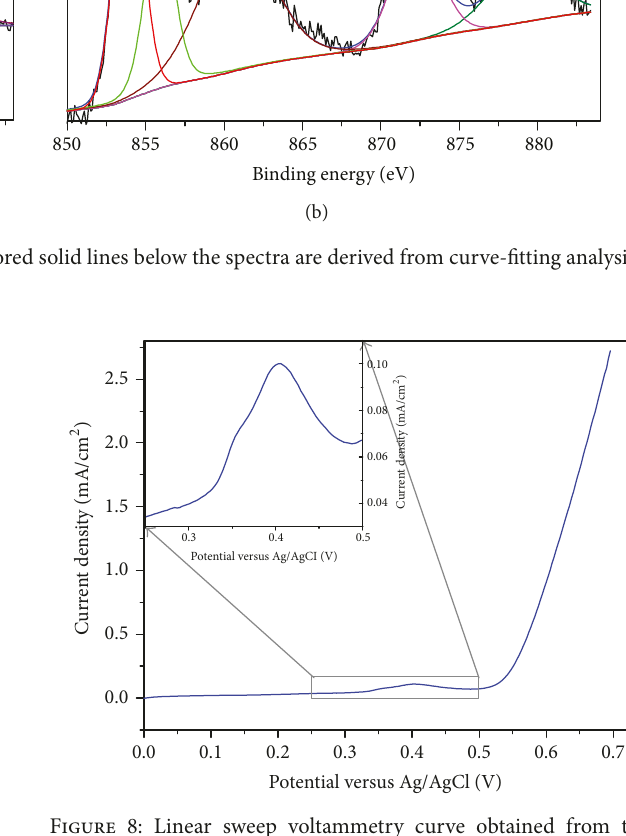
Figure 8: Linear sweep voltammetry curve obtained from the analysis of NiCo 2 O 4 inkjet-printed